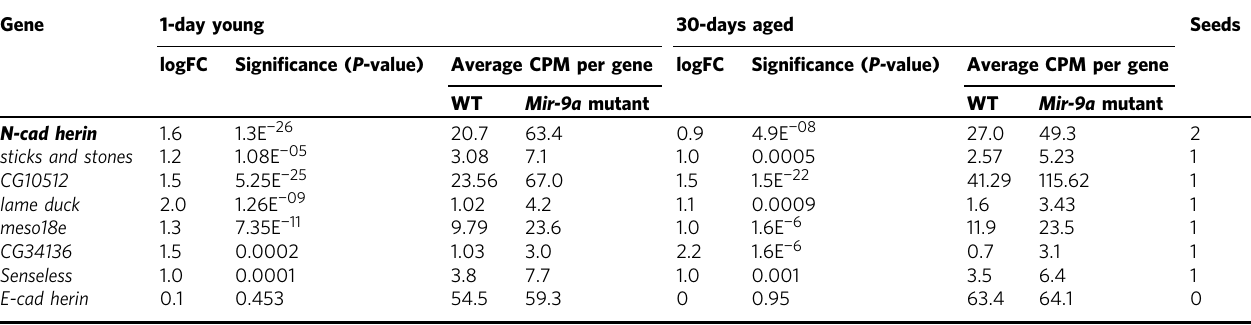
Table 1 Six potential mRNA targets for miR-9a in the